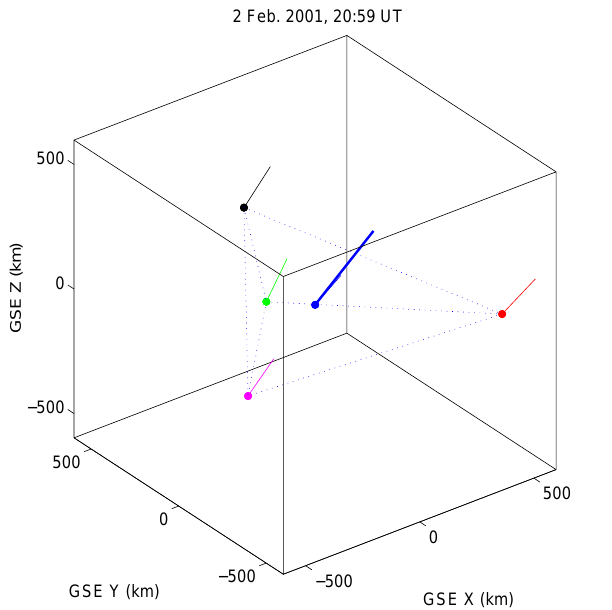
Fig. 10. Summary of the different estimates of the normal to the SLAMS at 20:59UT, in the same format as Fig. 7.